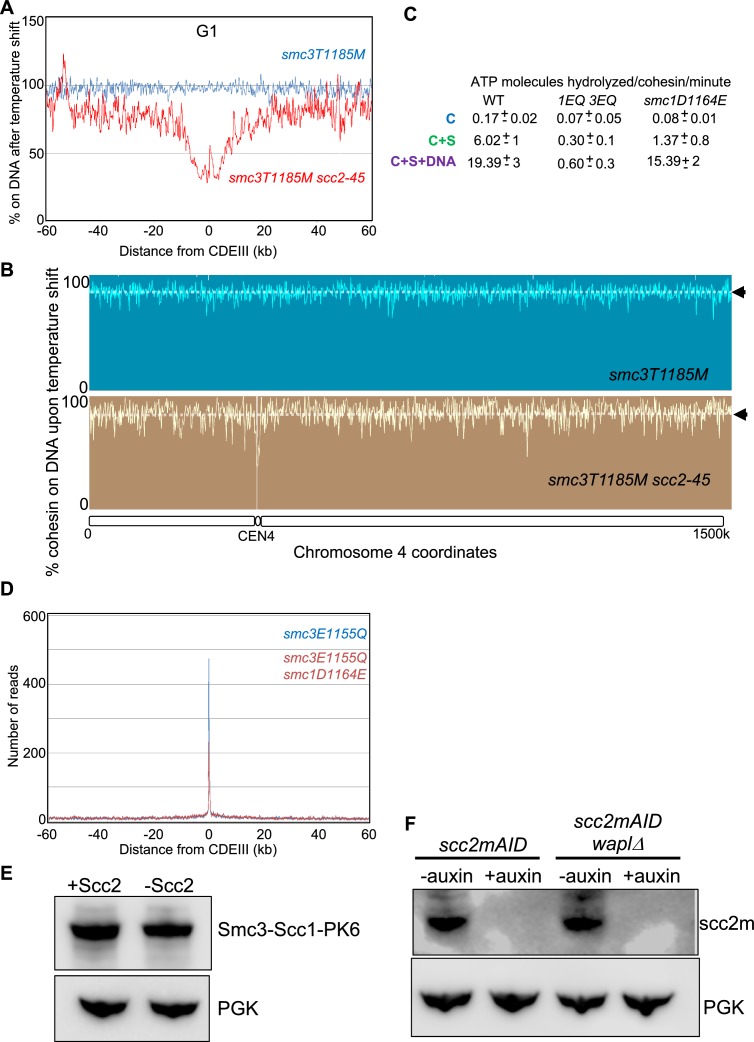
Wapl-independent release requires Smc ATPases.(A) Ratio of average cohesin levels before and after temperature shift of smc3T1185M (K27536) and smc3T1185M scc2-45 (K27537) strains arrested in late G1. (B) Data from (A) is plotted to show the percentage of cohesin that remains on DNA upon Scc2 inactivation (after temperature shift) along the entire chromosome 4. The median cohesin level along the entire chromosome 4 (dotted line) is marked with arrowheads. (C) ATPase activity of purified WT, smc1E1155Q smc3E1158Q and smc1D1164E mutant tetramer stimulated by Scc2. The rate of ATP hydrolysis (ATP molecules hydrolysed/Cohesin/minute) was measured either in the presence or absence of DNA as described in Materials and Methods. (D) Calibrated ChIP profile of smc3E1155Q (K17409) and smc3E1155Q smc1D1164E (25039). Cohesin ChIP profiles showing the number of reads at each base pair away from the CDEIII element averaged over all 16 chromosomes is shown. (E) The cultures expressing the Smc3-Scc1 fusion protein described in Figure 4B were analysed by western blotting against PK and PGK antibodies. (F) The scc2-3XmAID (K28095) and waplΔ scc2-3XmAID (28096) described in Figure 4D were analysed by western blotting with anti-mAID and anti-PGK antibodies before and after auxin addition.